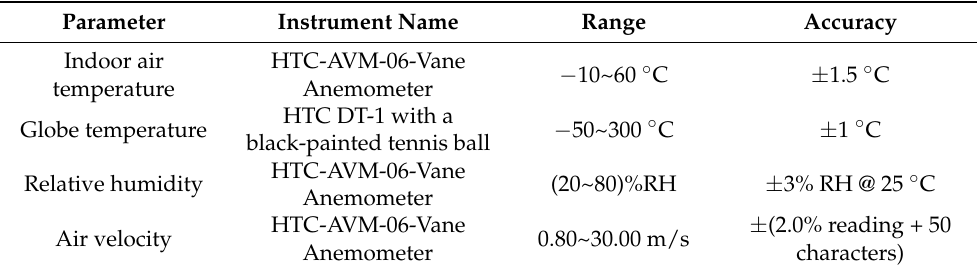
Table 2. Details of the instruments used during the field